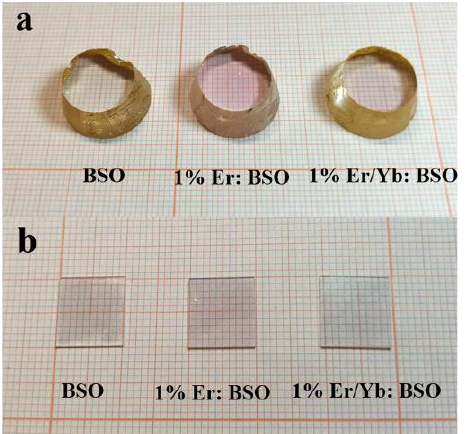
Figure 2. ( a ) Transparent pure BSO, Er: BSO, and Er/Yb: BSO crystals (10 mm in thickness) and ( b ) the polished slice of pure BSO, Er: BSO, and Er/Yb: BSO crystals (10 mm × 10 mm × 1 mm).